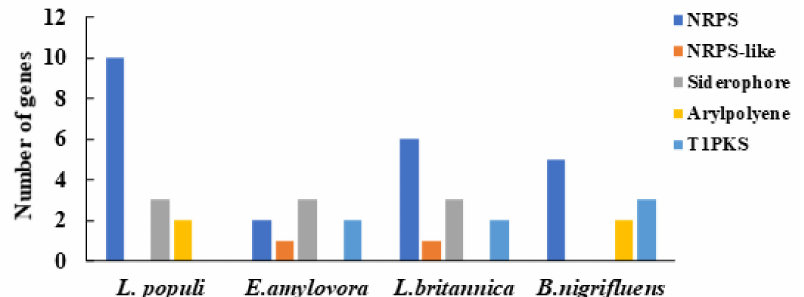
Figure 3. Putative genes encoding secondary metabolites of the four bacterial genomes. Genes involved in the secondary metabolism of the four bacterial genomes ( L. populi N-5-1, B. nigrifluens , E. amylovora , and L. britannica ) were predicted using the antiSMASH software. Non-ribosomal peptide synthetase cluster (NRPS), Siderophore cluster (Siderophore), Arylpolyene cluster (Arylpolyene), and Type I PKS (polyketide synthase) (T1PKS).